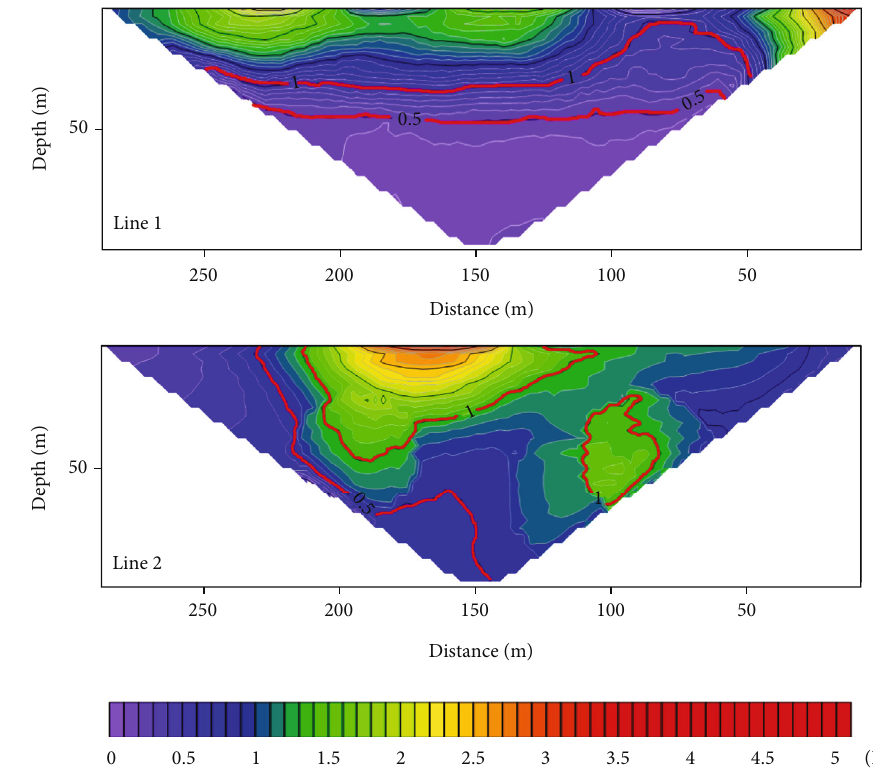
Figure 10: The permeability zoning